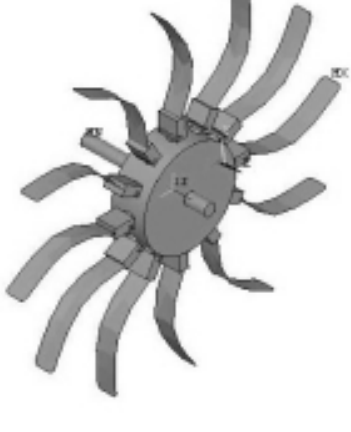
Fig. 4. Mode shape at 259.9 Hz of natural frequency (no rotation).